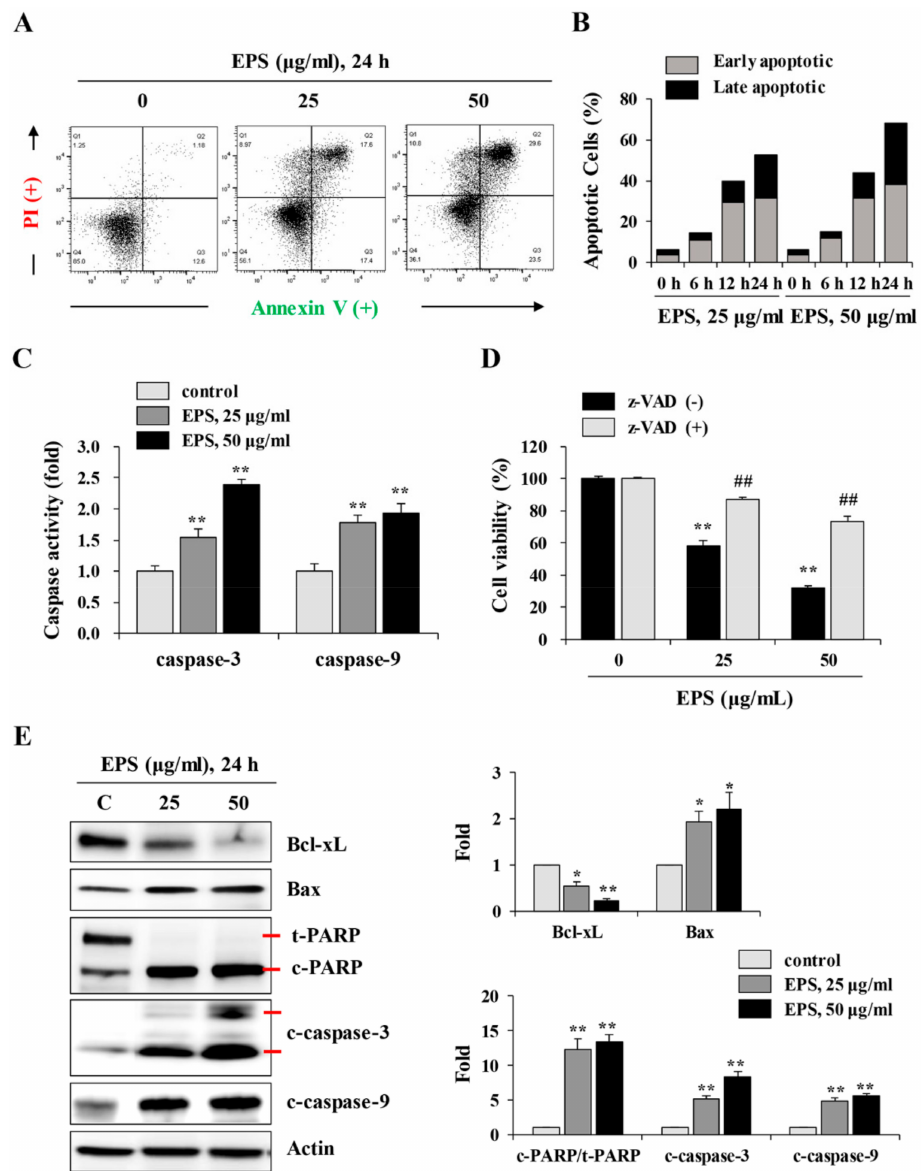
Figure 3. EPS induces apoptotic cell death in hiPSCs. ( A ) hiPSCs were treated with 25 and 50 µ g / mL EPS for 24 h, and then apoptosis was assessed with flow cytometry after annexin V / PI double staining. ( B ) After treating hiPSCs with 25 and 50 µ g / mL EPS for 6, 12, and 24 h, apoptotic cells population were measured by flow cytometry after annexin V / PI double staining. Bar graph shows the percentage of early apoptotic (annexin V +/ PI-) and late apoptotic (annexin V +/ PI + ) cells. ( C ) hiPSCs were treated with 25 and 50 µ g / mL EPS for 24 h, and the caspase-3, -8, and -9 activities in equal amounts of cell lysates were determined. Relative activity compared with EPS-untreated hiPSCs was calculated and data are expressed as the mean ± SD from triplicate samples. ( D ) hiPSCs pre-treated with or without z-VAD (20 µ M) for 30 min were treated with 25 and 50 µ g / mL EPS. After 24 h, cell viability was